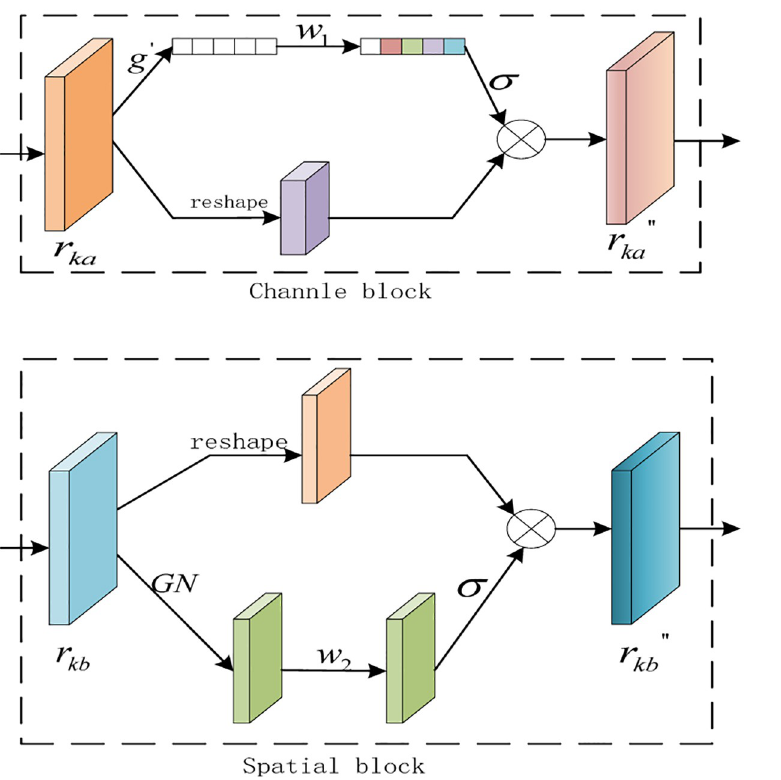
Fig 2. The details of the channle and spatial